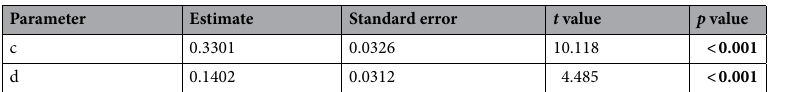
Table 4. Parameter estimates from the power function by least squares method on the relationship of duration and bias (estimated species richness of eBird vs. average estimated species richness of BBS). The power function is depicted in Eq. (8) with parameters (g and h) to be estimated. Residual standard error 0.3954 on 562 degrees of freedom. Significant parameters are shown in